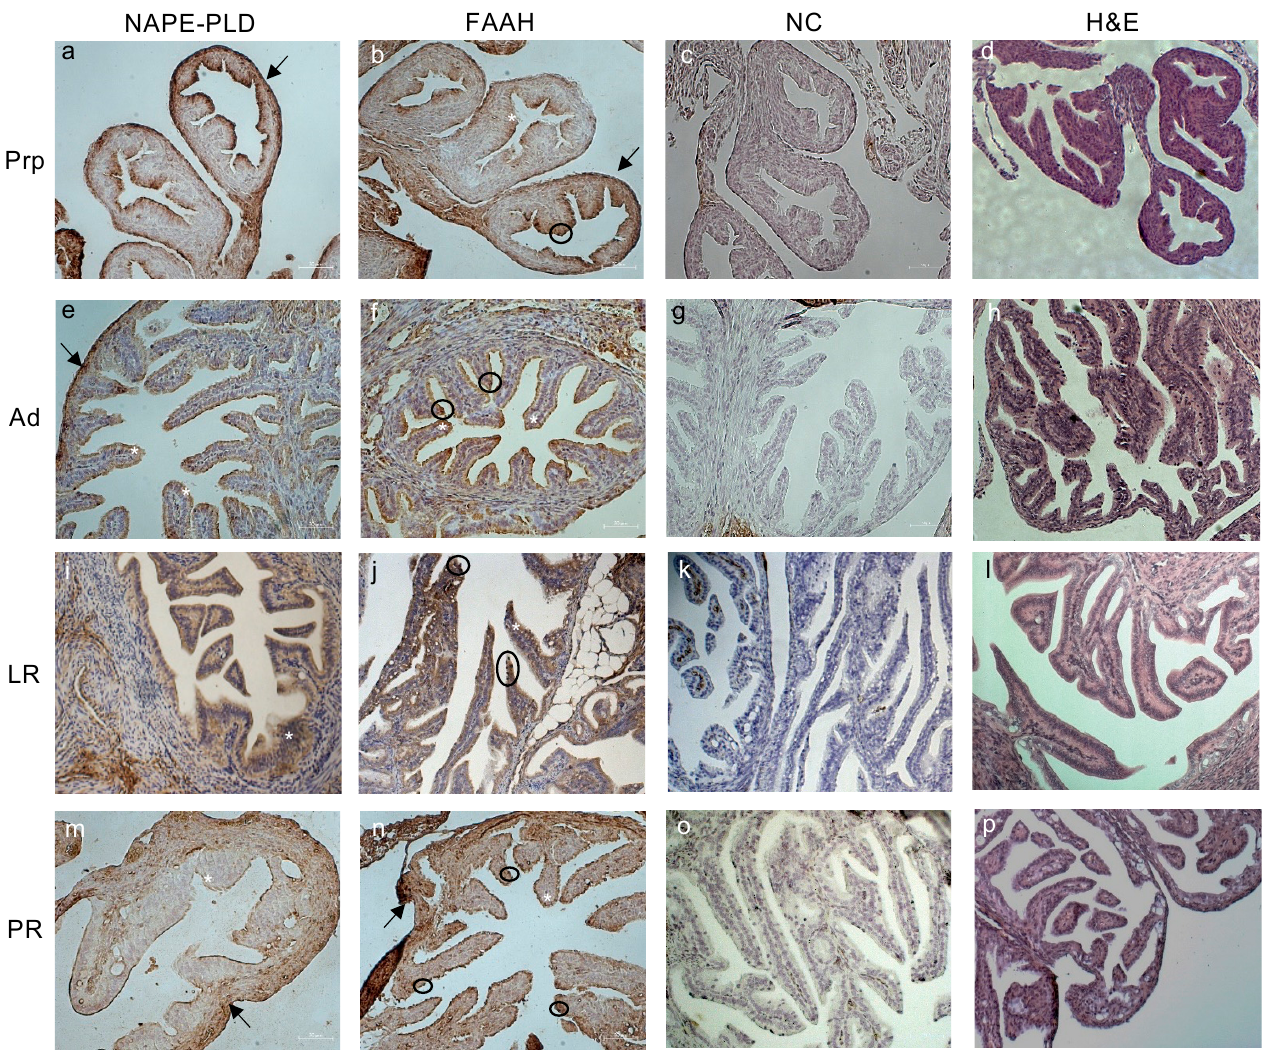
Figure 3. Representative images of tissue localization of NAPE-PLD and FAAH in mice oviducts during reproductive aging. Representative images of NAPE-PLD ( a , e , i , m ) and FAAH ( b , f , j , n ) im- munoreactivity in prepubertal (PrP), adult (Ad), late reproductive (LR), and post-reproductive (PR) mouse oviducts. Negative controls (NC; c , g , k , o ) and H&E staining ( d , h , l , p ) are also presented. Annotations—Arrows: serosa; circle: secretory cells; asterisks: ciliated cells. Scale bar: 50 µ m. Magnification: ×